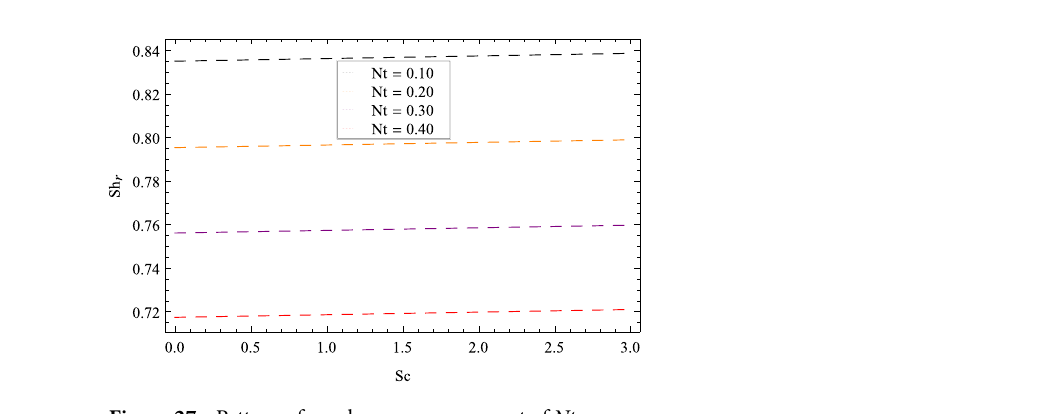
Figure 27. Pattern of graph curves on account of Nt .